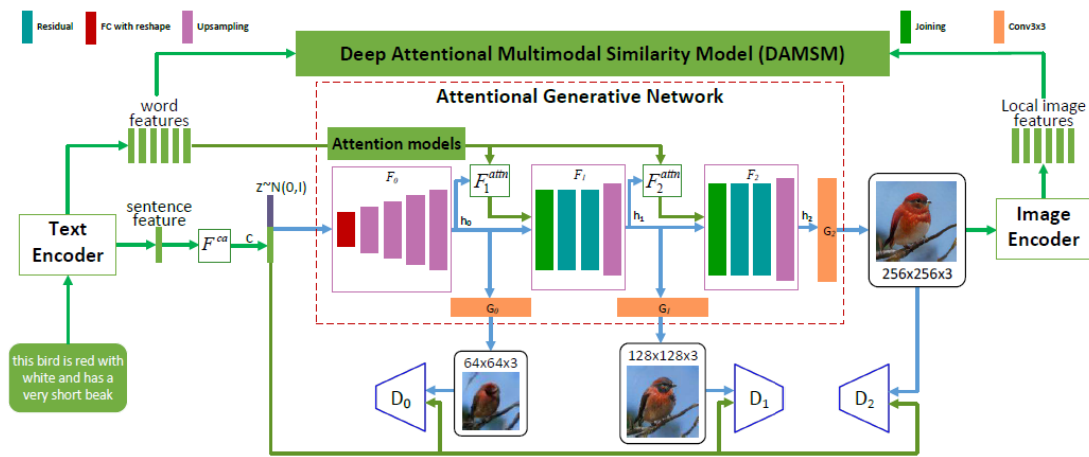
Figure A1. The original architecture of the AttnGAN. Source of the figure: [41].